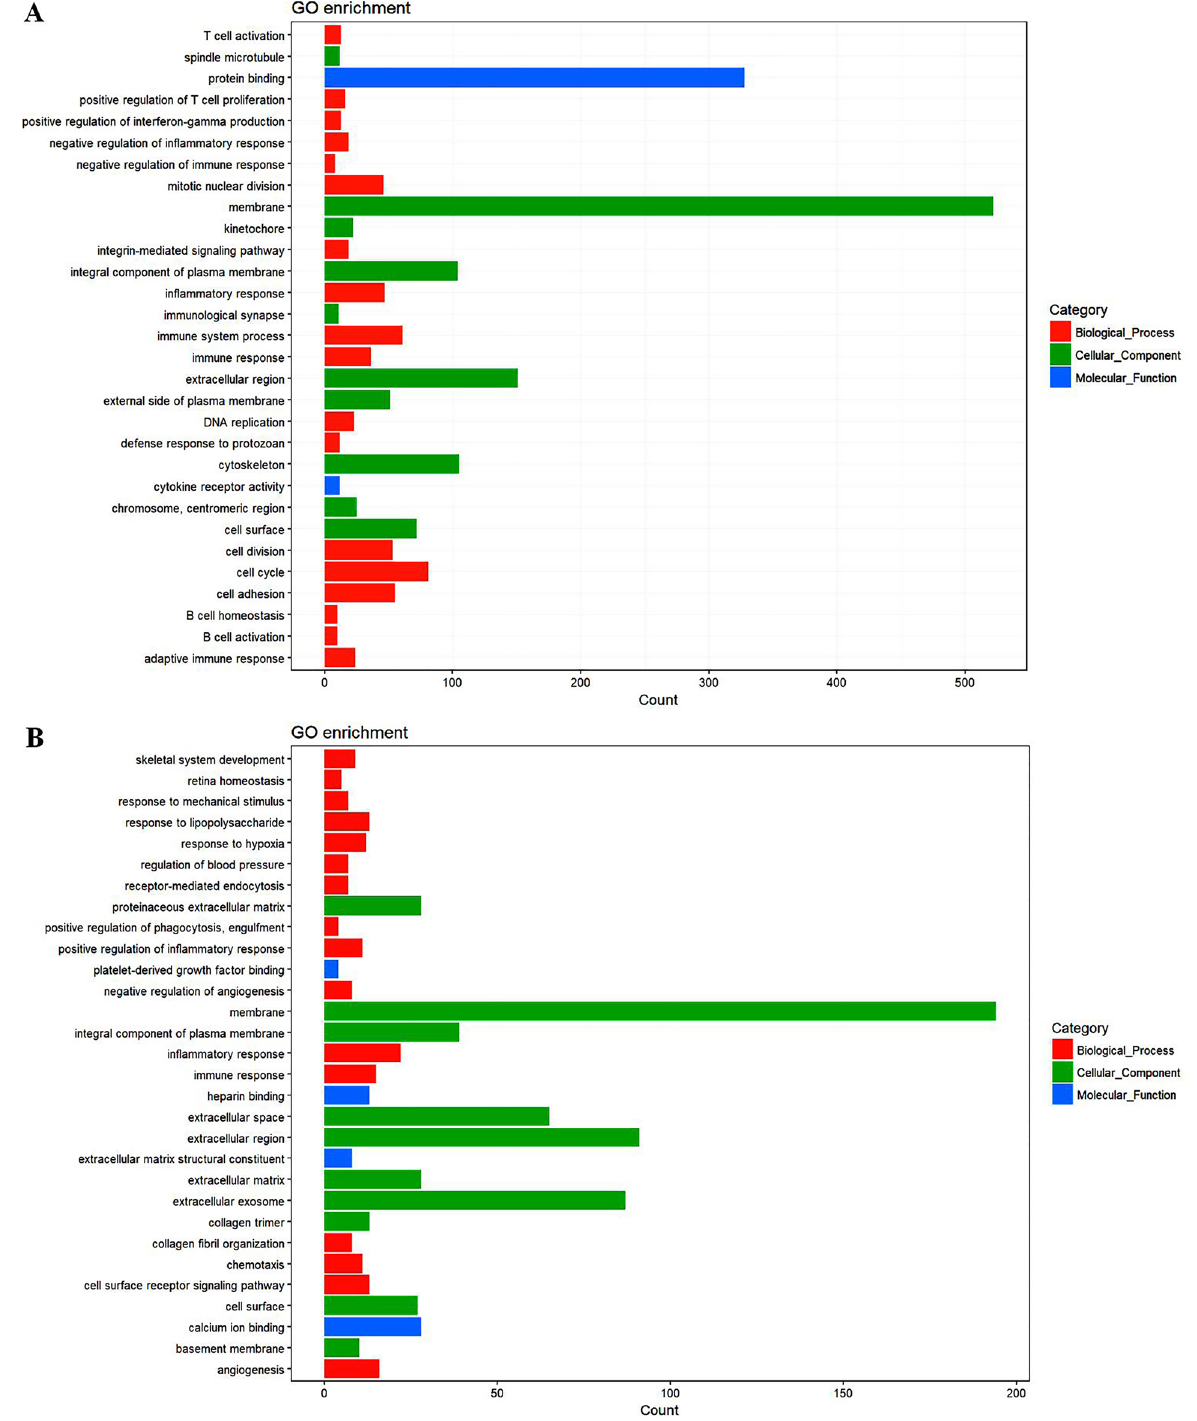
Figure 4. ( A ) Gene ontology classification of assembled unigenes in ARP mice compared with healthy mice. The DEGs genes were classified into three functional categories: biological process, cellular component and molecular function. The x-axis shows the number of genes in a category. The y-axis shows the specific category of genes in that main category. ( B ) Gene ontology classification of assembled unigenes in ARP mice treated with or without DXM + GM